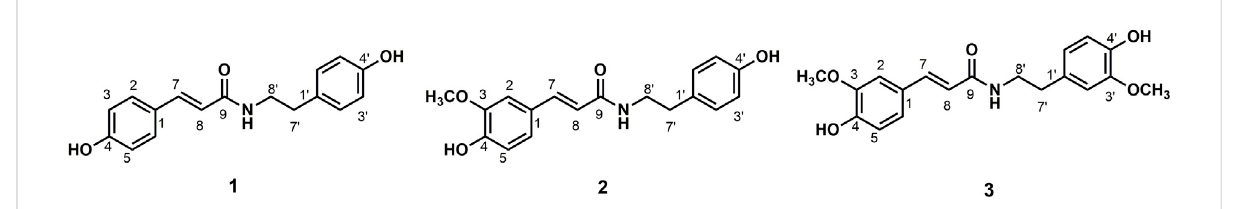
FIGURE 1 Chemical structure of compounds 1 , 2 , and 3